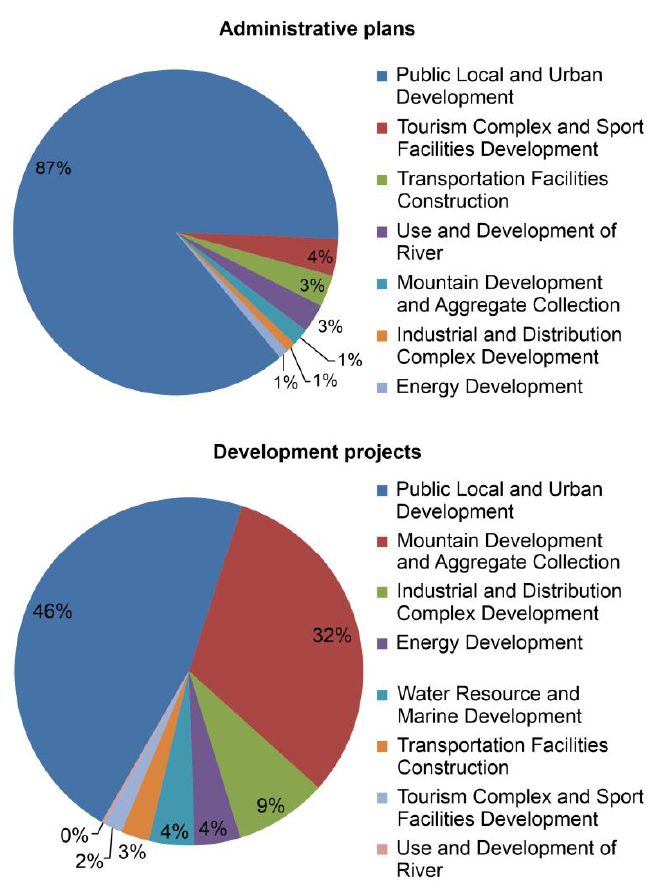
Figure 3. DIA results by area of administrative plans and development projects (2015–2017).